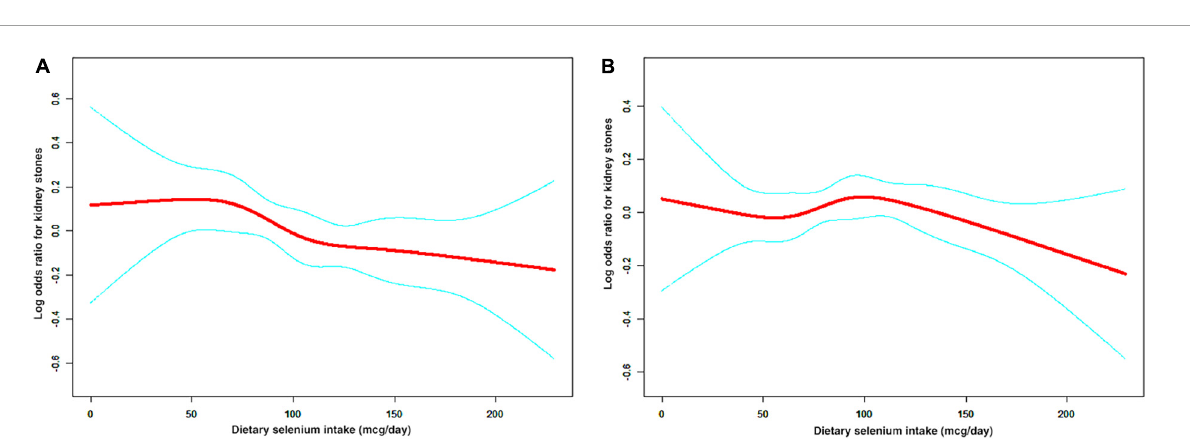
FIGURE3 The non-linear relationship between dietary selenium intakes and the risk of kidney stones in stratified analysis by age. (A) age < 50 years group, (B) age ≥ 50 years group.